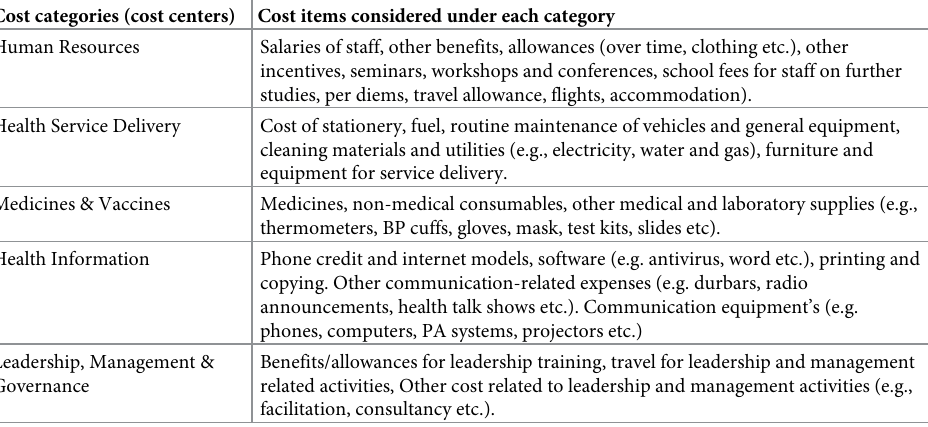
Table 1. Costs items considered, classified into WHO health system building blocks. Cost categories (cost centers) Cost items considered under each category Human Resources Salaries of staff, other benefits, allowances (over time, clothing etc.), other incentives, seminars, workshops and conferences, school fees for staff on further studies, per diems, travel allowance, flights, accommodation).